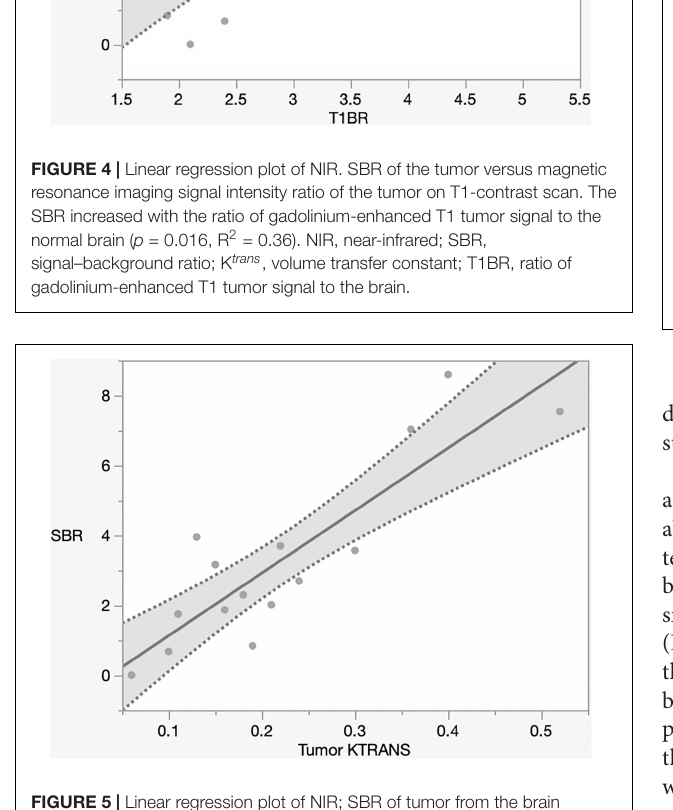
FIGURE 5 | Linear regression plot of NIR; SBR of tumor from the brain surface versus K trans . The SBR increased with K trans on magnetic resonance imaging ( p < 0.0001, R 2 = 0.77). NIR, near-infrared; SBR, signal–background ratio; K trans , volume transfer constant.